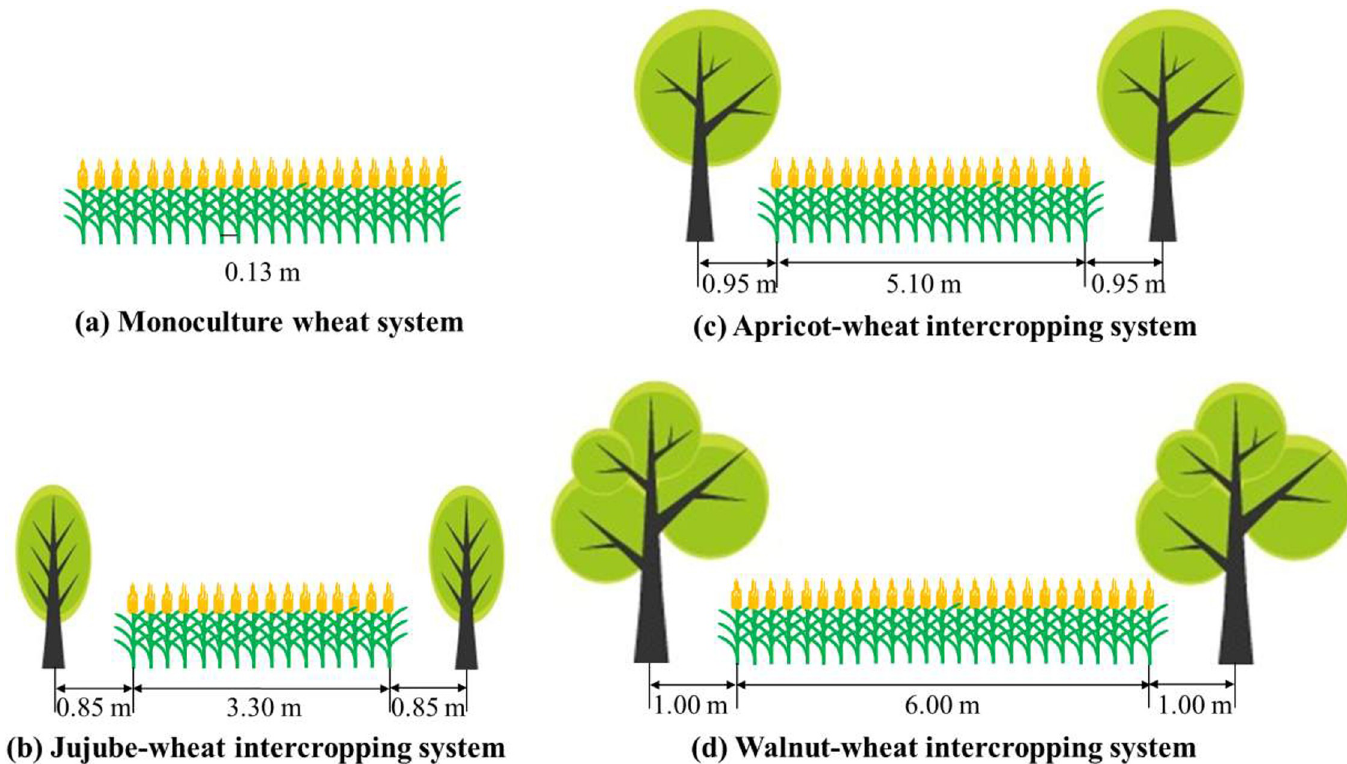
Fig 1. Schematic illustration of planting patterns in monoculture wheat and 3 different fruit tree-wheat based intercropping systems. This figure represents a single site with each of the four planting patterns. There were 5 samples from different tree rows forming a single replication.